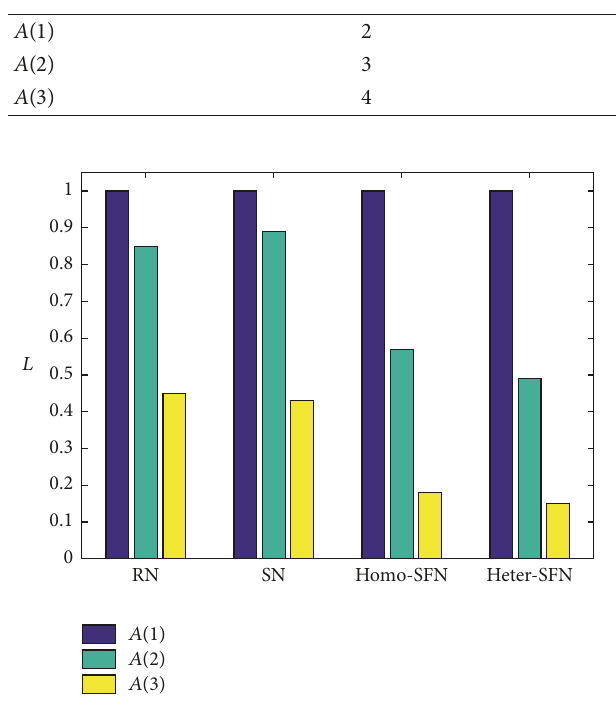
Figure 16: Failure size 𝐿 with varying types of matrix 𝐴 under max- status attack ( 𝑅 = 2 , 𝜀 = 0.6